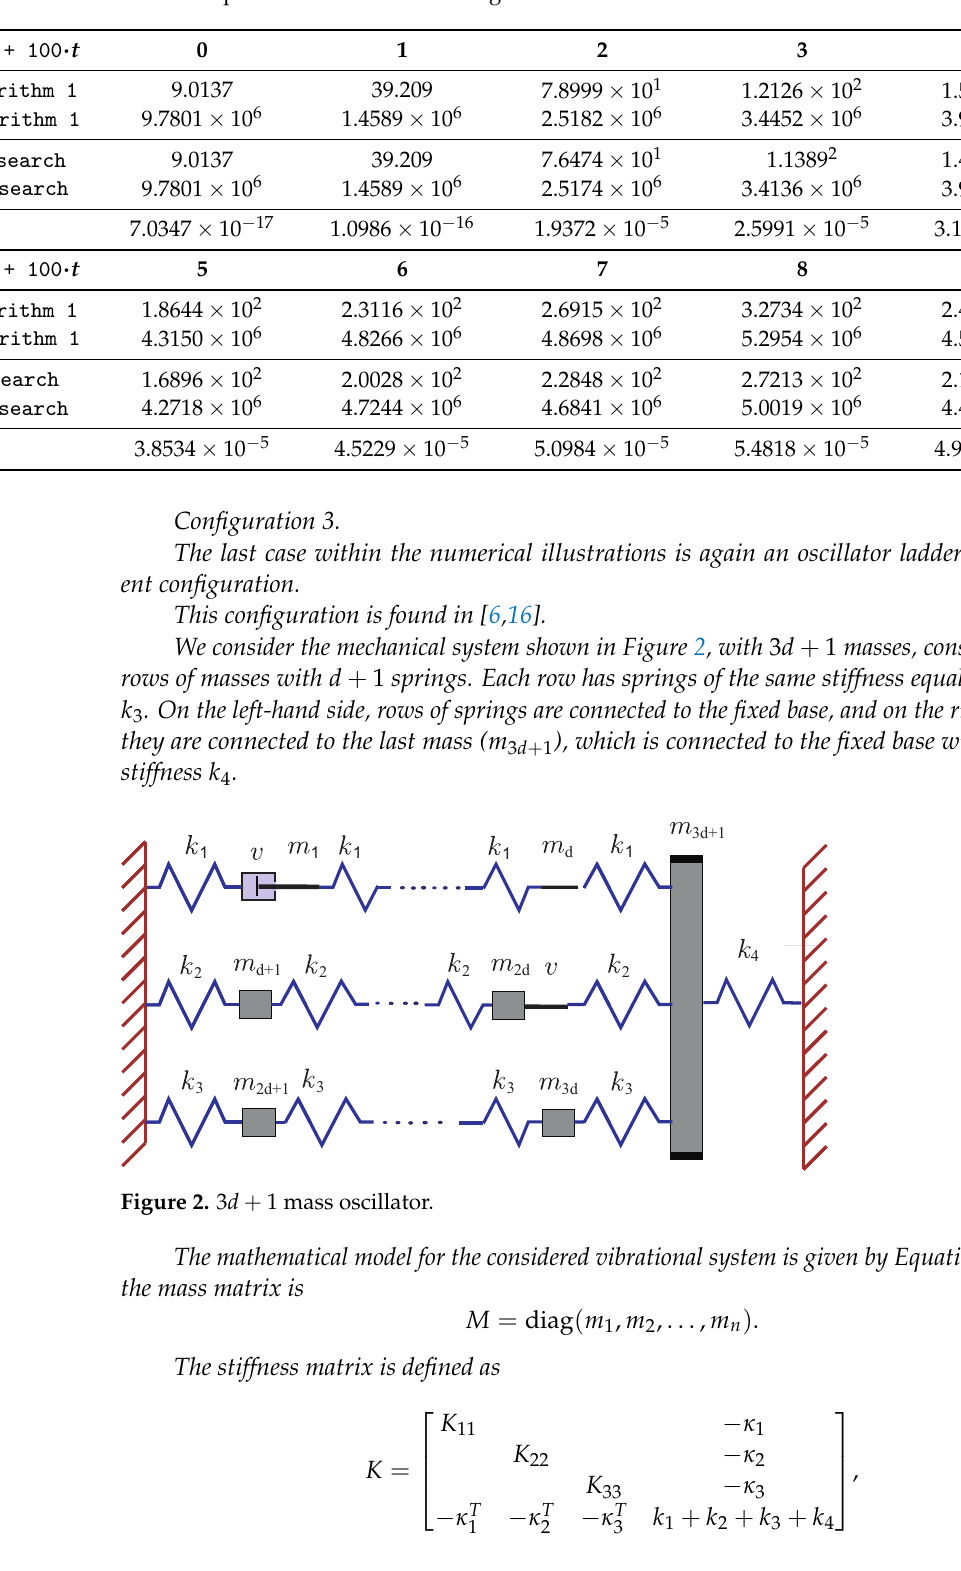
Table 3. Optimal viscosities for Configuration 2.